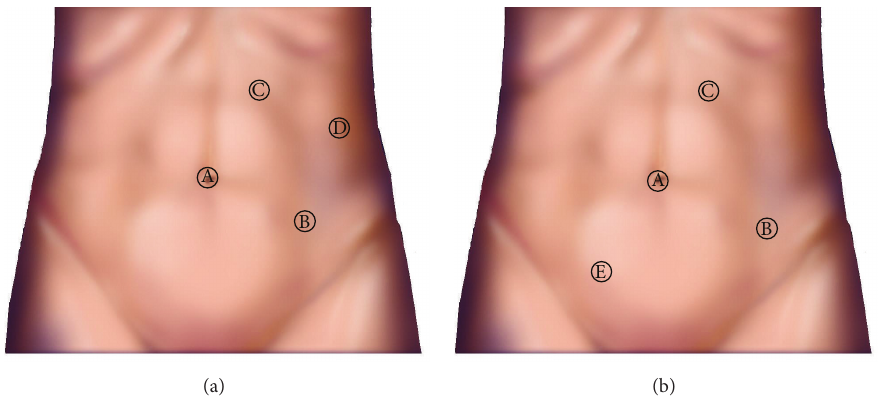
Figure 3: Port placement. (a) Right flank position. (b) Head-down